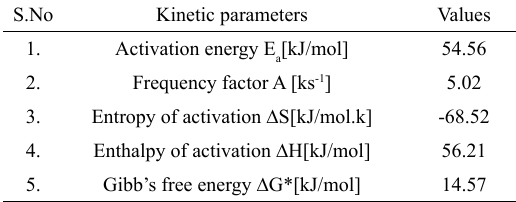
Figure 5. TG and DTA Curve of GIP. Table 1. Kinetic parameters of GlP